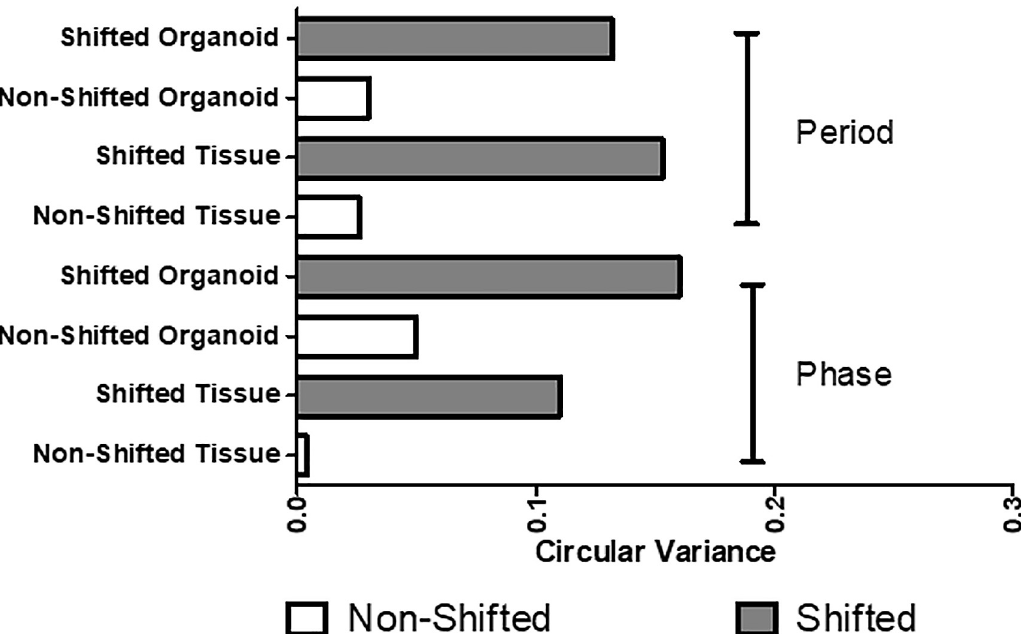
Fig 2. Circular variance of circadian period and phase measures is increased in LD shifted vs. non-shifted in Per2::Luc mice colon tissue and organoids. Circular variance quantifies the variability in circadian data. The top section depicts the circadian period of the colon tissue and organoids from shifted and non-shifted mice. The period of the shifted mice for both the organoids and tissue are much more variable than the periods for the non-shifted organoids and tissue. Similarly, the acrophase (phase) for the colon organoids and tissue from shifted mice has much more variability than the colon organoids and tissue from the non-shifted mice. This demonstrates that LD shifting mice creates more variability (disruption) in their colon tissue circadian clock and that colon organoids maintain the circadian rhythm disruption of the disrupted host colon tissue. Data are for n = 8-10/group.